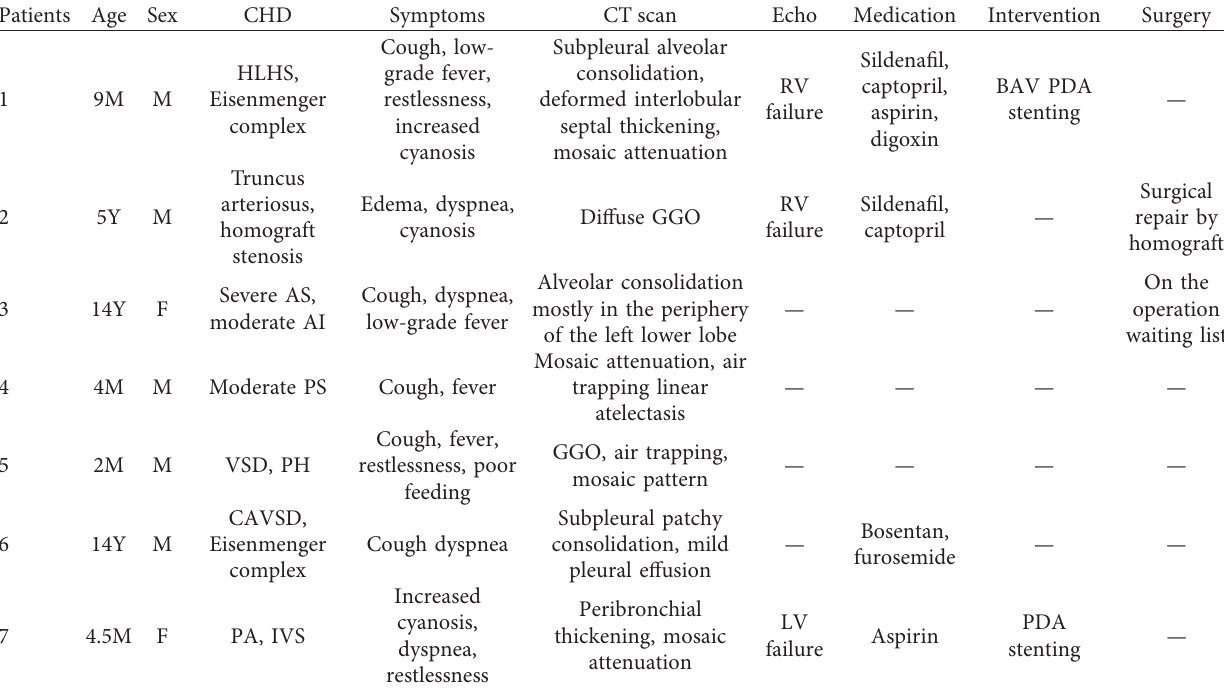
Table 1: Demographic data, symptoms, CT scan, echocardiographic data, and treatment history of the patients. Patients Age Sex